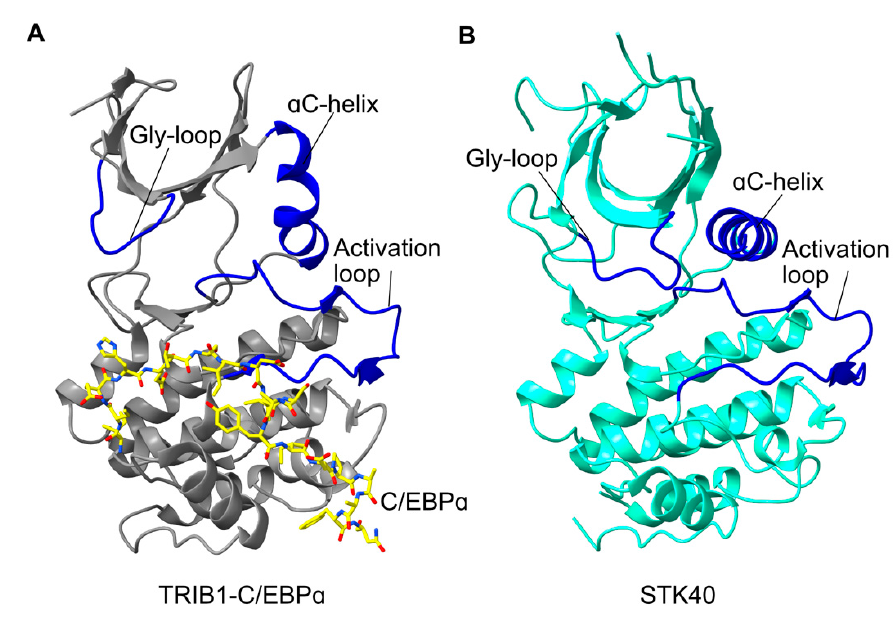
Figure 2. Comparison of activated TRIB1 structure with STK40. ( A ) Structure of TRIB1 (grey) in complex with a C/EBP α peptide (yellow; PDB 6dc0). ( B ) Structure of the STK40 pseudokinase domain (cyan; PDB 5l2q). Key features are shown in blue and labelled accordingly.